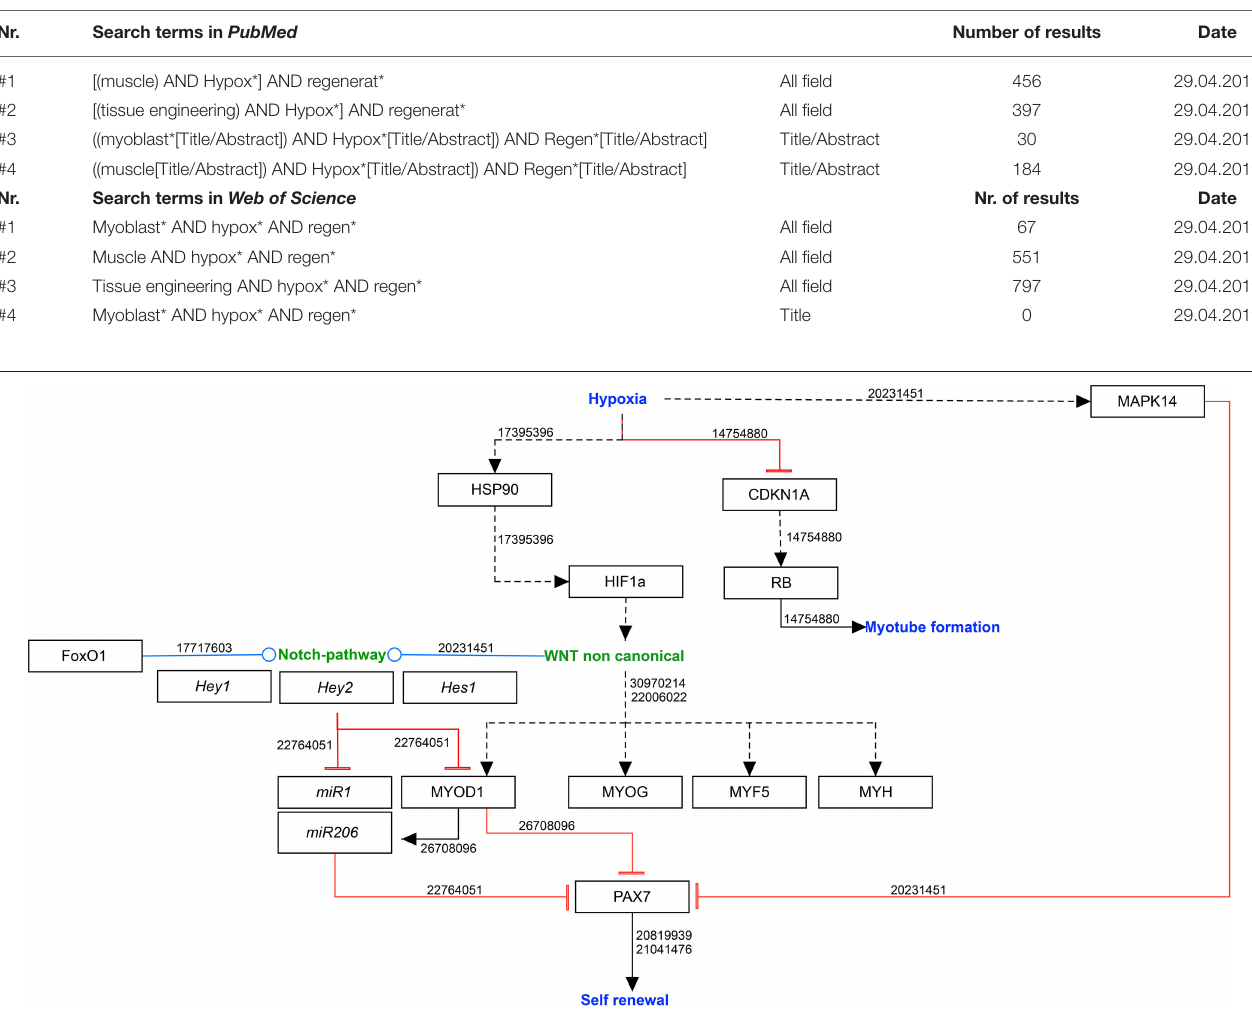
FIGURE 1 | Molecular mechanisms involved in self-renewal of satellite cells in hypoxia. Black arrows: activation of the signaling pathway/protein/molecule. Blunt red arrow: inhibition of the signaling pathway/protein/molecule. Round blue arrow: interaction between two pathways. Numbers: PubMed-IDs.